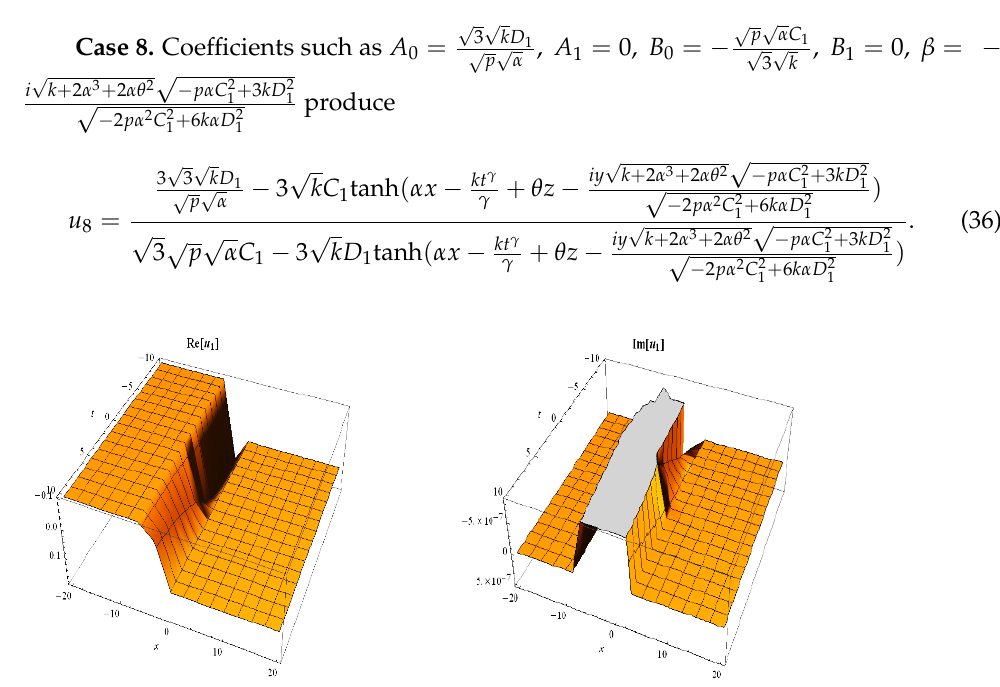
Figure 10. Three-dimensional graphs of imaginary and real part of (29).